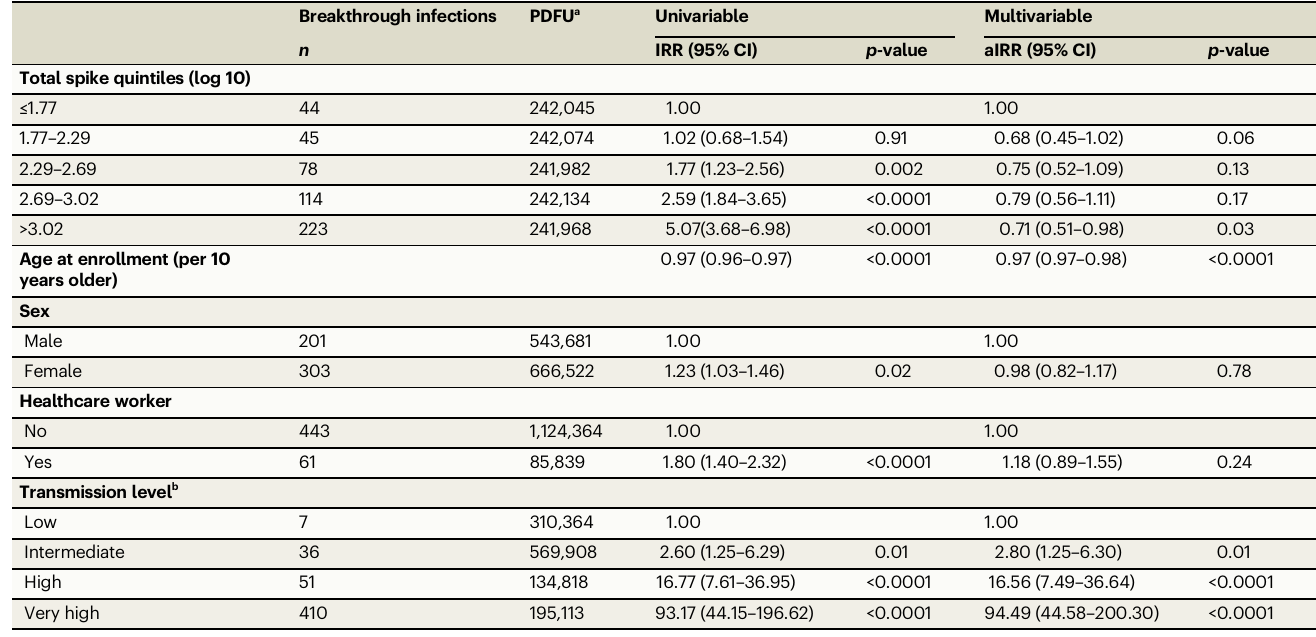
Table 2 | Factors associated with breakthrough infection ( n =